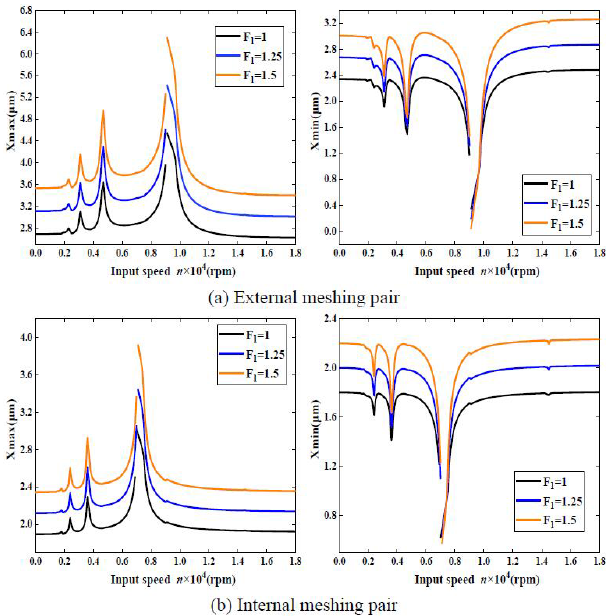
Figure 6. Effect of stiffness on the vibration response curve.